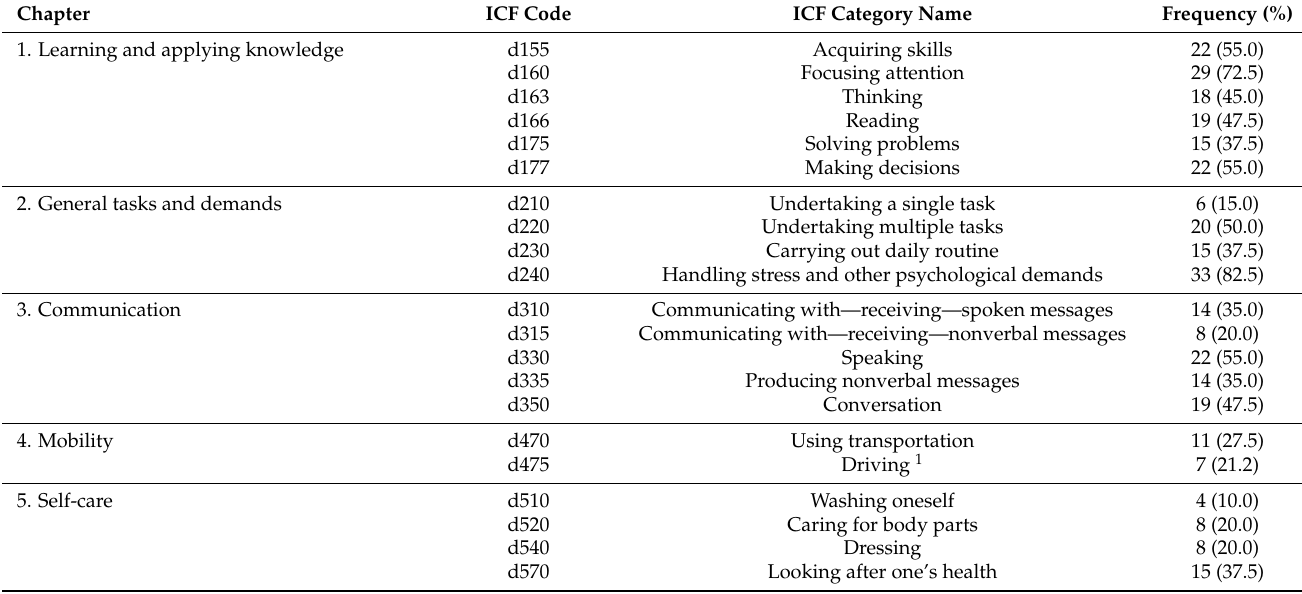
Table 3. Frequency and percentage of participants with impairment * on the ICF categories of the Activities and participation